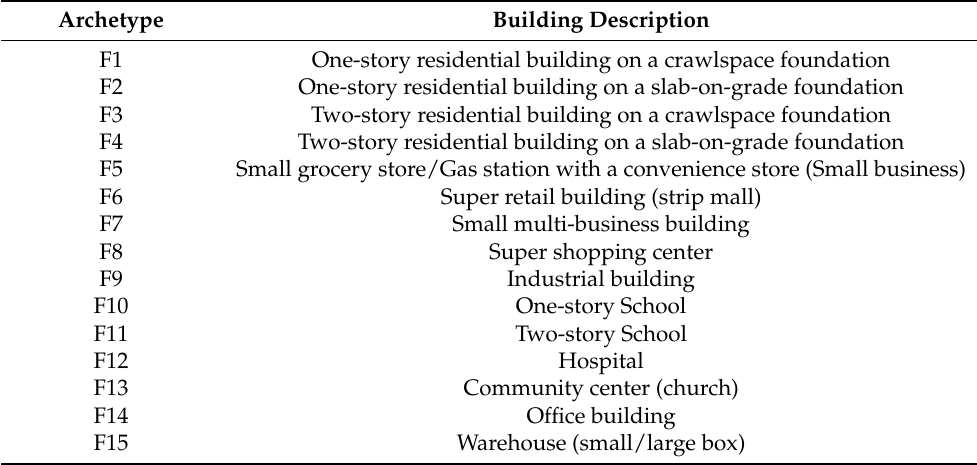
Table 2. Flood building archetypes description